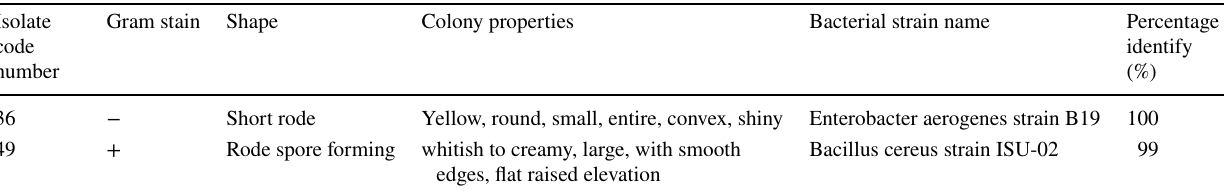
Table 5 Identification of selected isolates